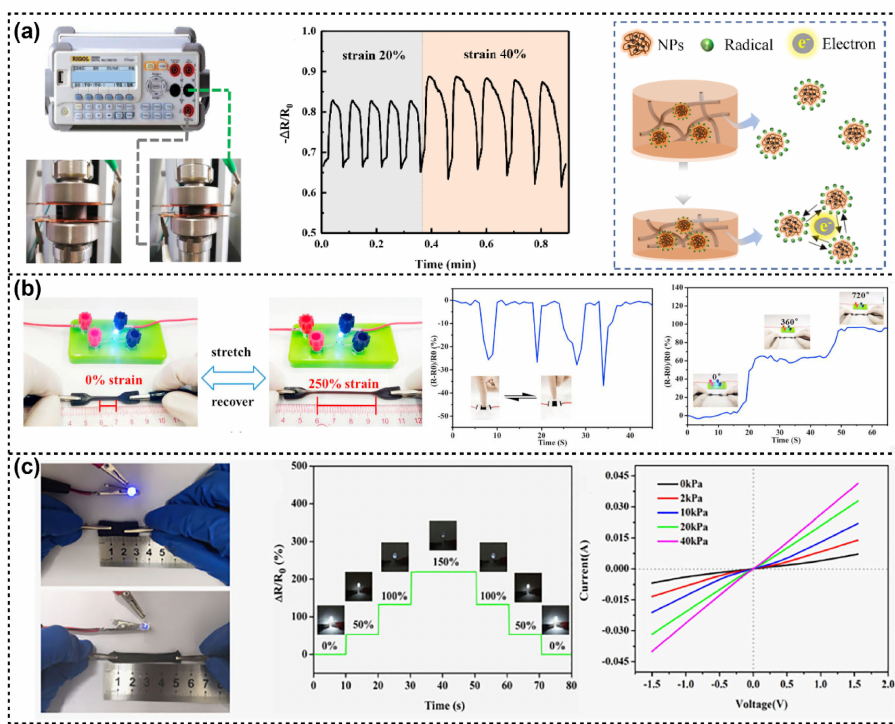
Figure 5. ( a ) Schematic diagram of the test setup, the resistive response of PVA/Lig–Ag hydrogels under repeated loading and unloading cycles at 20% and 40% compression, and the pressure-sensitive mechanism of PVA/Lig–Ag hydrogels. Reproduced with permission from ref. [76]. Copyright 2021, Elsevier. ( b ) The photograph shows the response of the LED to the applied strain of 0–250, real- time response to compression signals, and relative resistance changes of Ag@DEL torsion at 0 ◦ , 360 ◦ , and 720 ◦ , respectively. Reproduced with permission from ref. [77]. Copyright 2020, Elsevier. ( c ) Conductivity schematic diagram of PC/CNF/LC hydrogel pressure sensor, the responsivity of PC/CNF/LC hydrogel pressure sensor under different stretch lengths, current-voltage characteristics of PC/CNF/LC composite under different pressure. Reproduced with permission from ref.